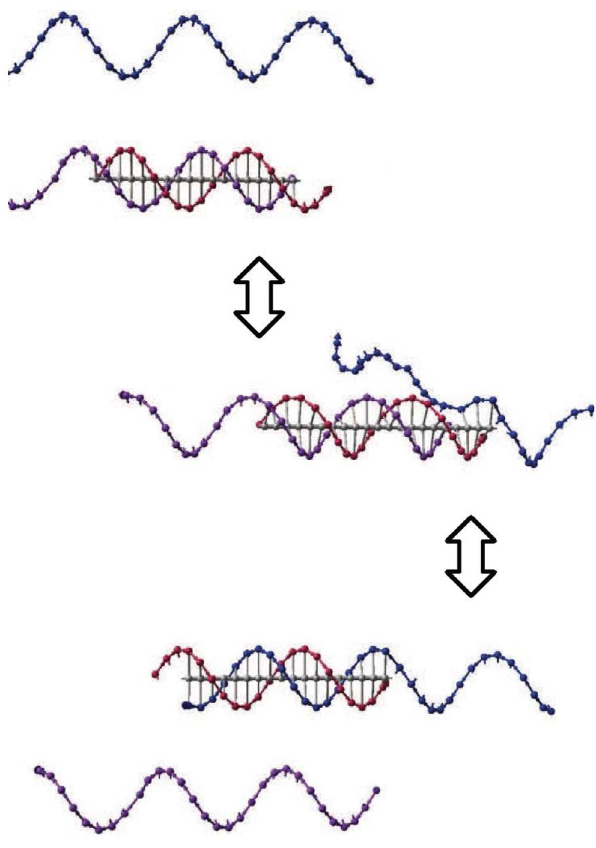
Figure 1. Thresholding reaction of a DNA neuron.